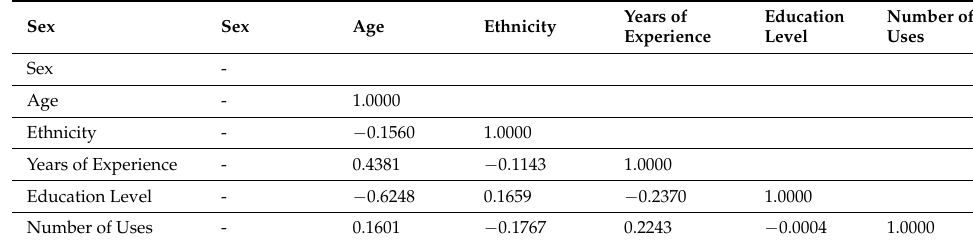
Table 2. Correlation between